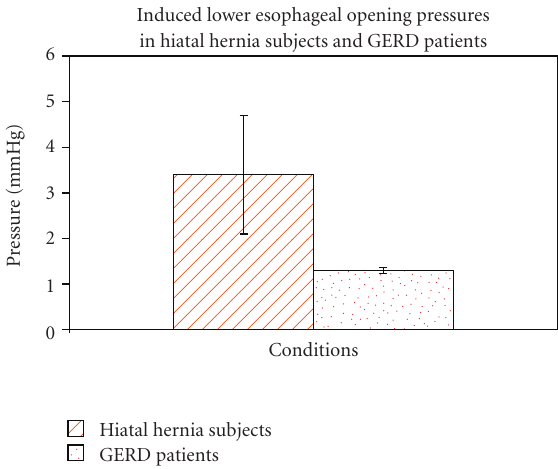
Figure 6: This graph shows the hiatal opening pressures of the two patterns of normal subjects, subjects with hiatal hernia and the GERD